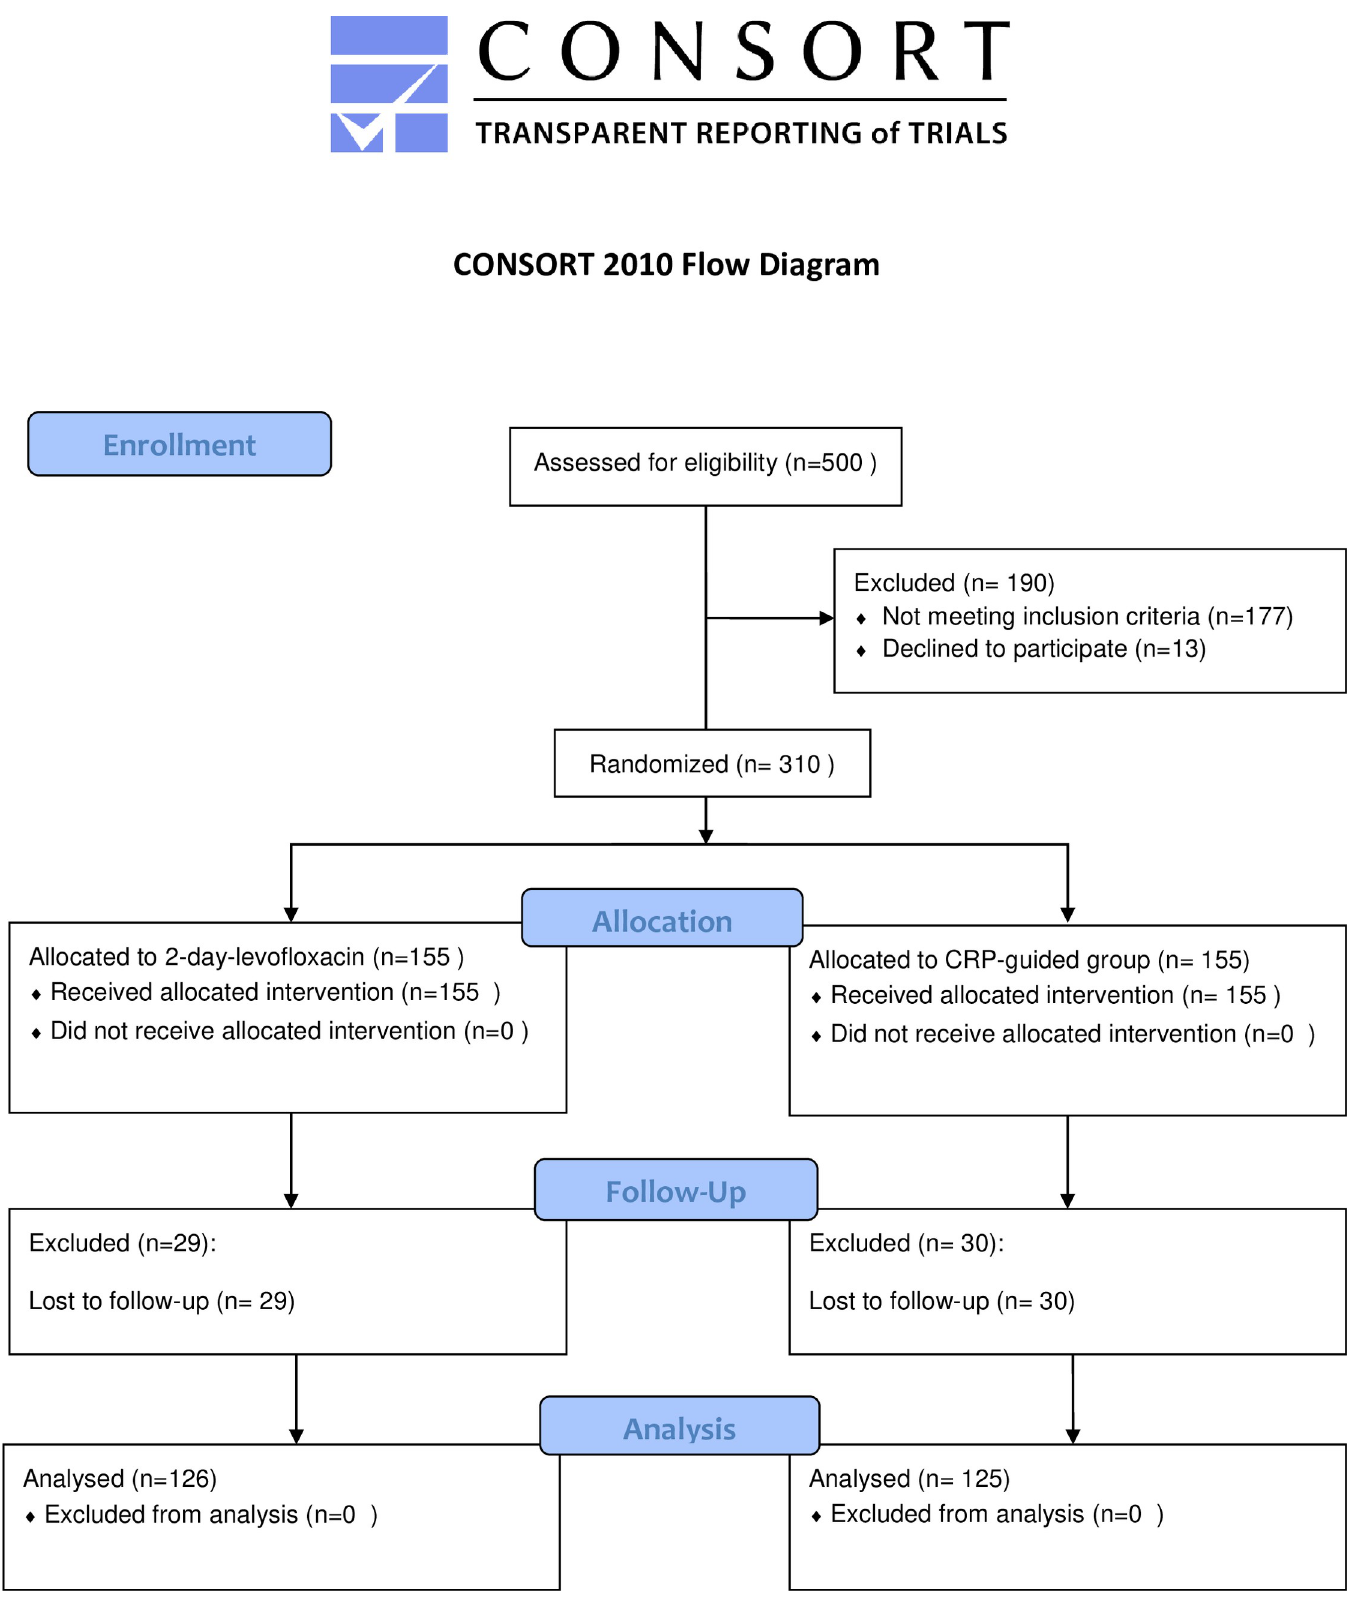
Fig 1. Flow chart. https://doi.org/10.1371/journal.pone.0251716.g001 PLOS ONE | https://doi.org/10.1371/journal.pone.0251716 May 20,